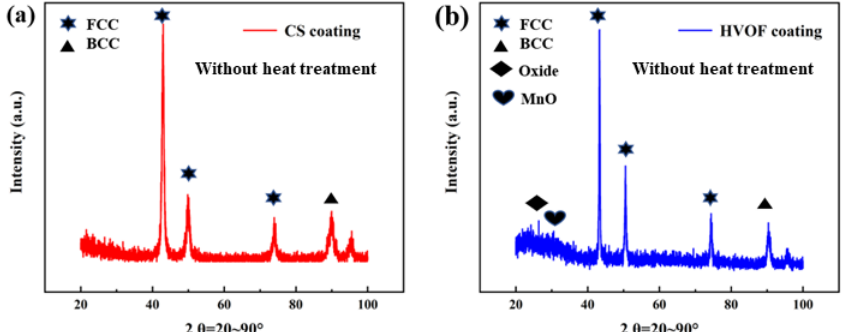
Figure 3. XRD patterns of CoCrFeNiMn high-entropy alloy coatings prepared by CS and HVOF without heat treatment. ( a ) CS coating; ( b ) HOVF coating.